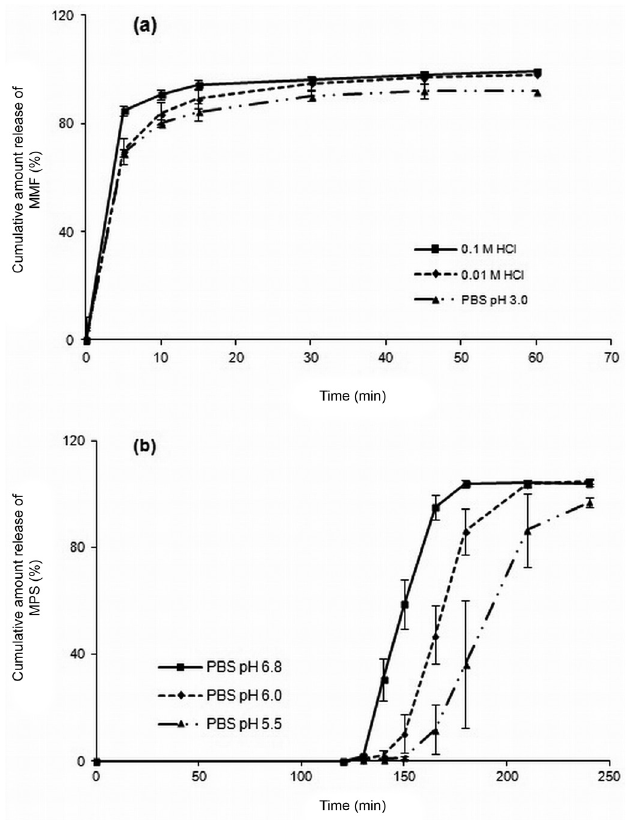
FIGURE 2 - Cumulative amount release for (a) MMF-IR in